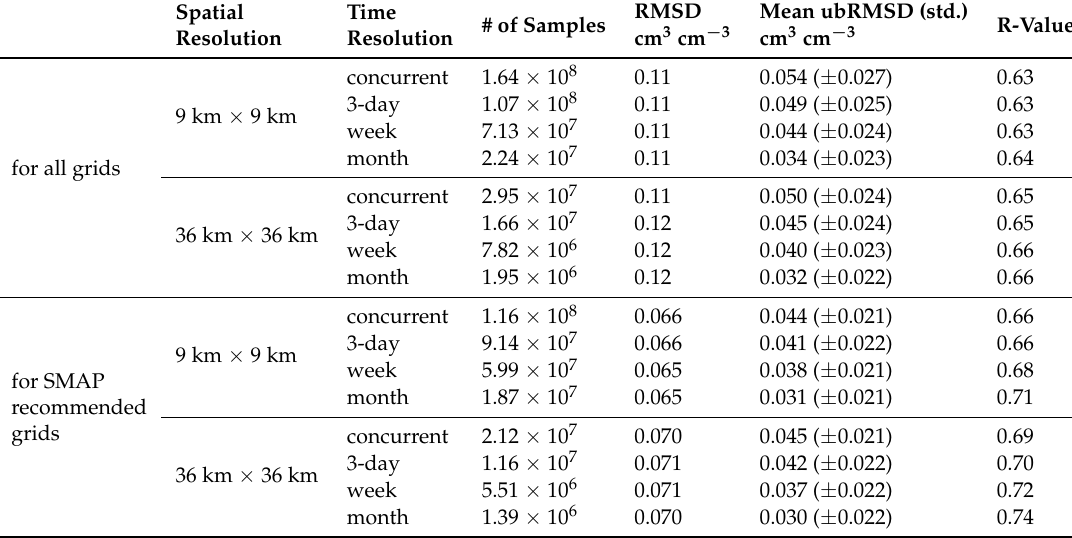
Table 1. Overall performance evaluation metrics computed between CYGNSS and SMAP SM predictions at different spatial and temporal averaging levels for about 3 years (from March 2017 to December